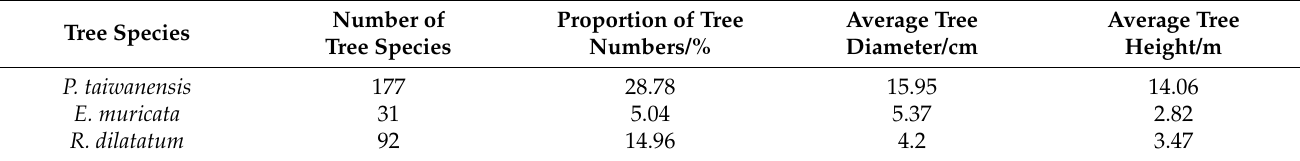
Table 1. Information on sample plot and tree species.